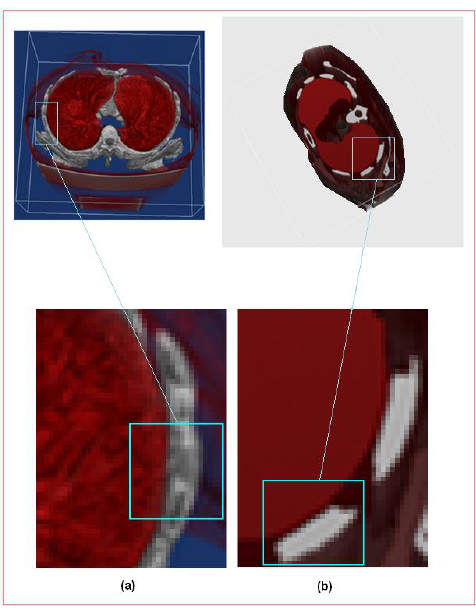
Figure 25. Chest and lung at 600% magnification (a) Ray casting (b) this work.